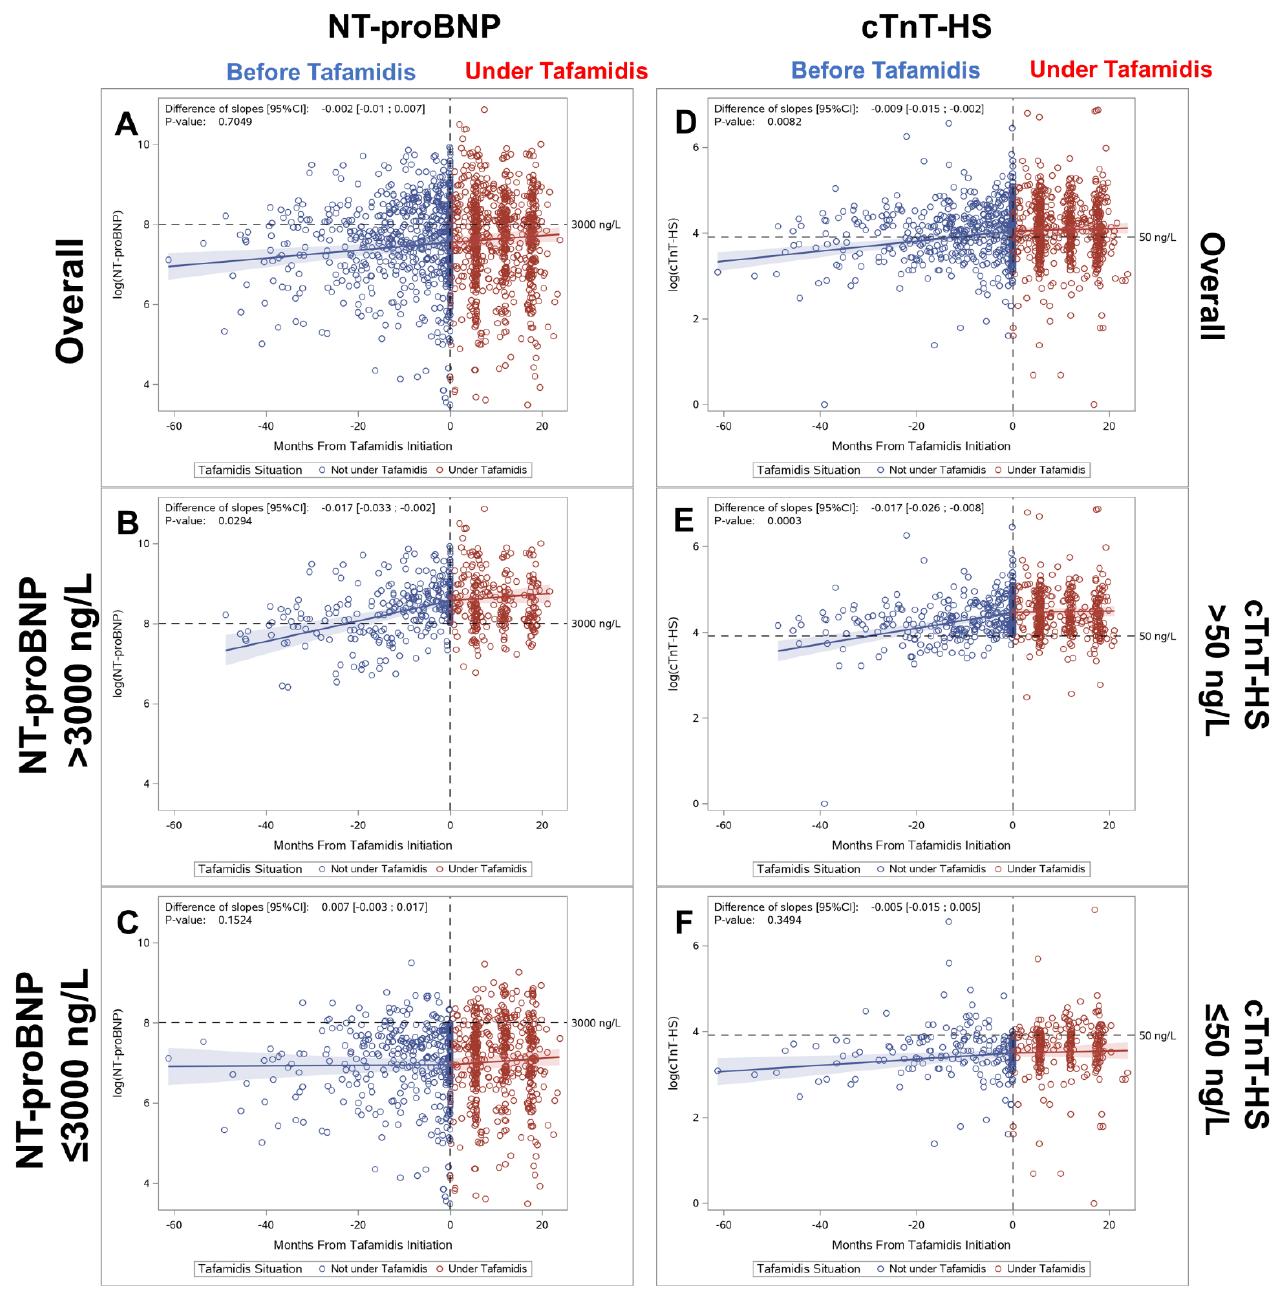
Figure 6. Regression in Cohort B Patients before (blue) and after initiation of tafamidis (red): Of log NT-proBNP ( A ) and depending on NT-proBNP > 3000 ng/L ( n = 92) ( B ) or NT-proBNP ≤ 3000 ng/L when tafamidis was initiated ( n = 156) ( C ); Regression of log cTnT-HS ( D ) and depending on cTnT-HS > 50 ng/L when tafamidis was initiated ( n = 139) ( E ); or with cTnT-HS ≤ 50 ng/L ( n = 98) ( F ).